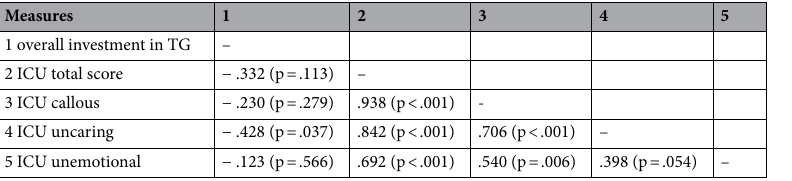
Table 3. Spearman correlations of the overall investment in TG, ICU total score and ICU subscale in JO/CD. JO/CD = male juveniles who committed serious violent offenses and met criteria of conduct disorder.